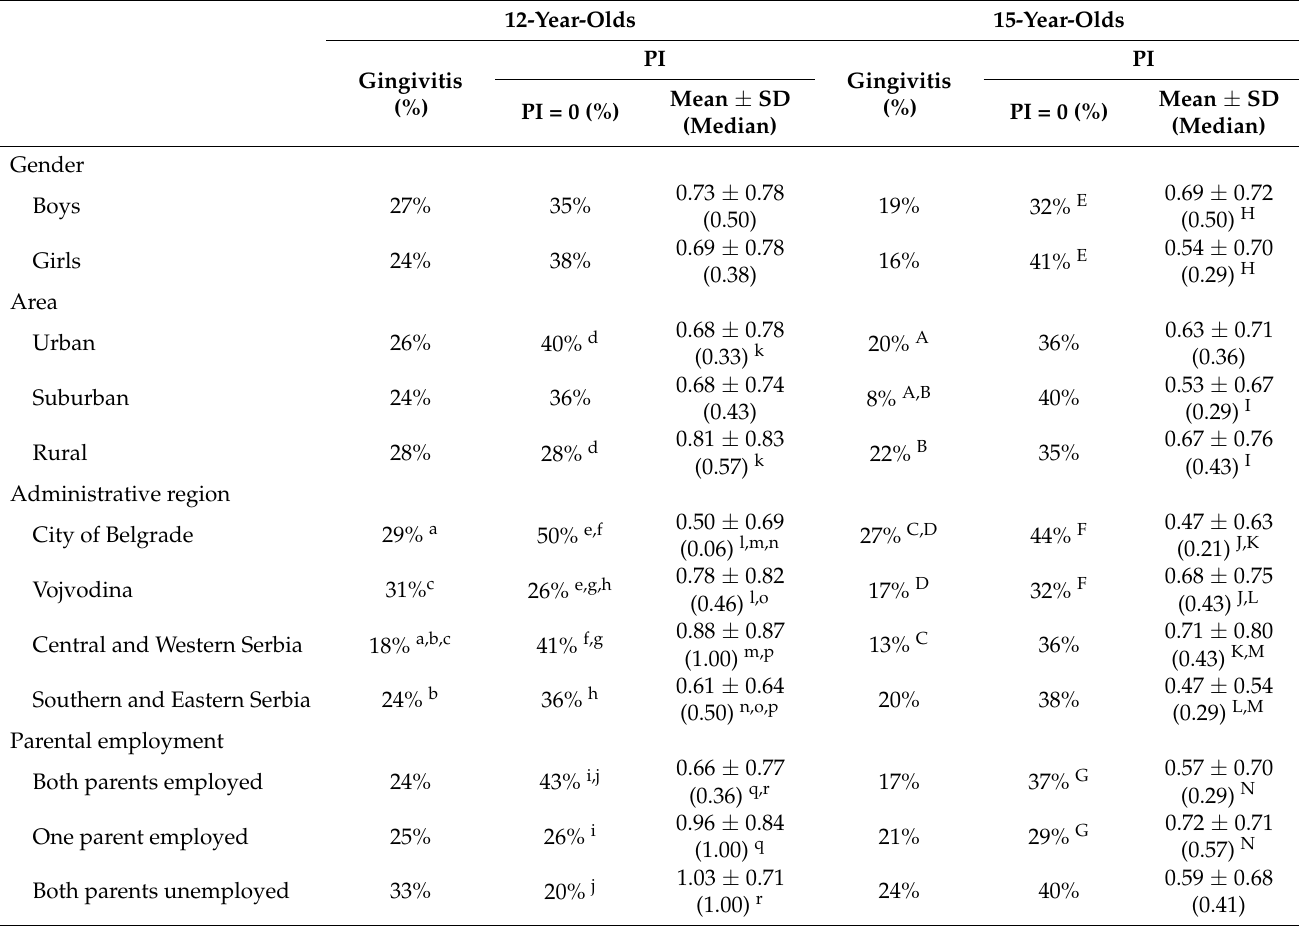
Table 5. Gingival health and oral hygiene.